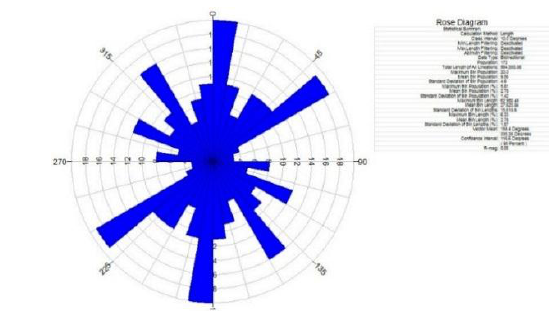
Figure 10. Rose diagram of lineament extract from satellite image.